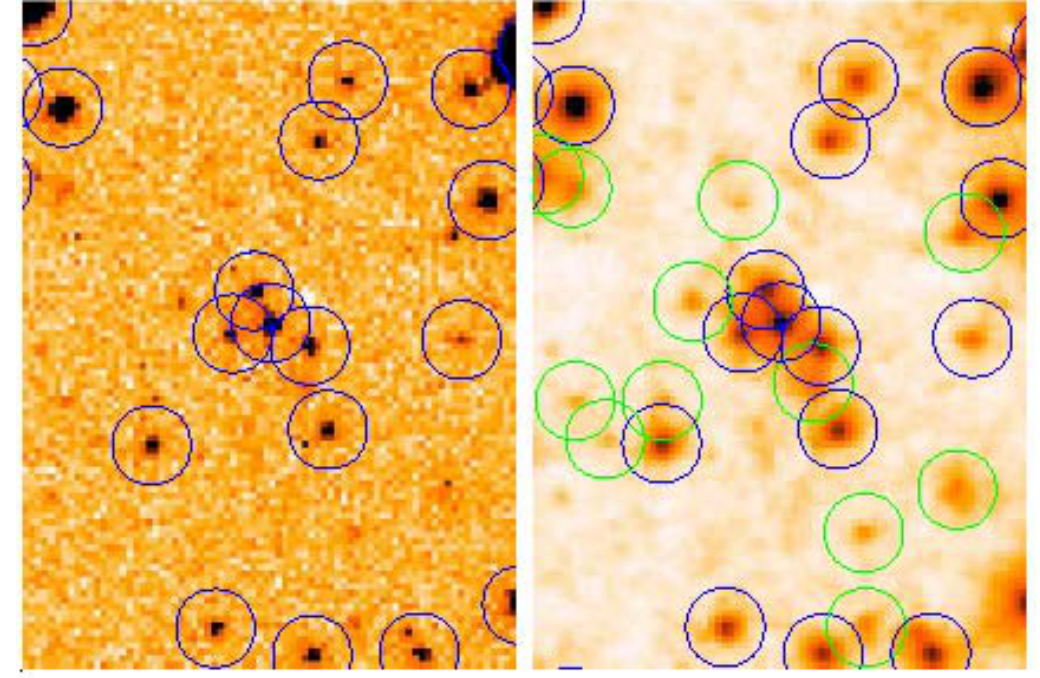
Figure 2. Raw image (left) and its AWMLE restoration (right) of an image obtained as in Figure 1 with the CCD camera of the NESS-T BNC program. Left: the detected stars are circled in blue. Right: the newly detected stars (not detected in the raw image) are circled in green. Both detection processes were performed with SExtractor algorithm [14], by using the same input